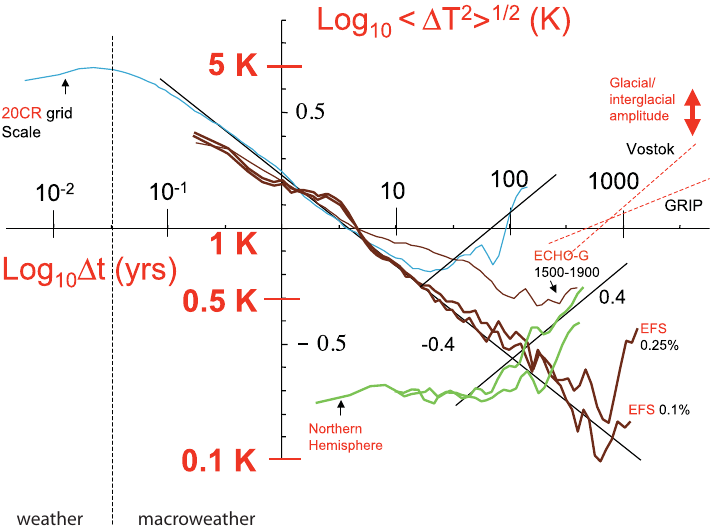
Fig. 8. Grid-scale, forced pre-20th C RMS fluctuations: the same as Fig. 7 except for grid-scale analyses (the green Northern Hemisphere multiproxy curves were added for reference, see Fig. 4). Again, the EFS model has low frequencies that are too weak, but even ECHO-G has weak variability and the low frequency tendency is not clear (i.e. is it starting to rise at 1t ≈